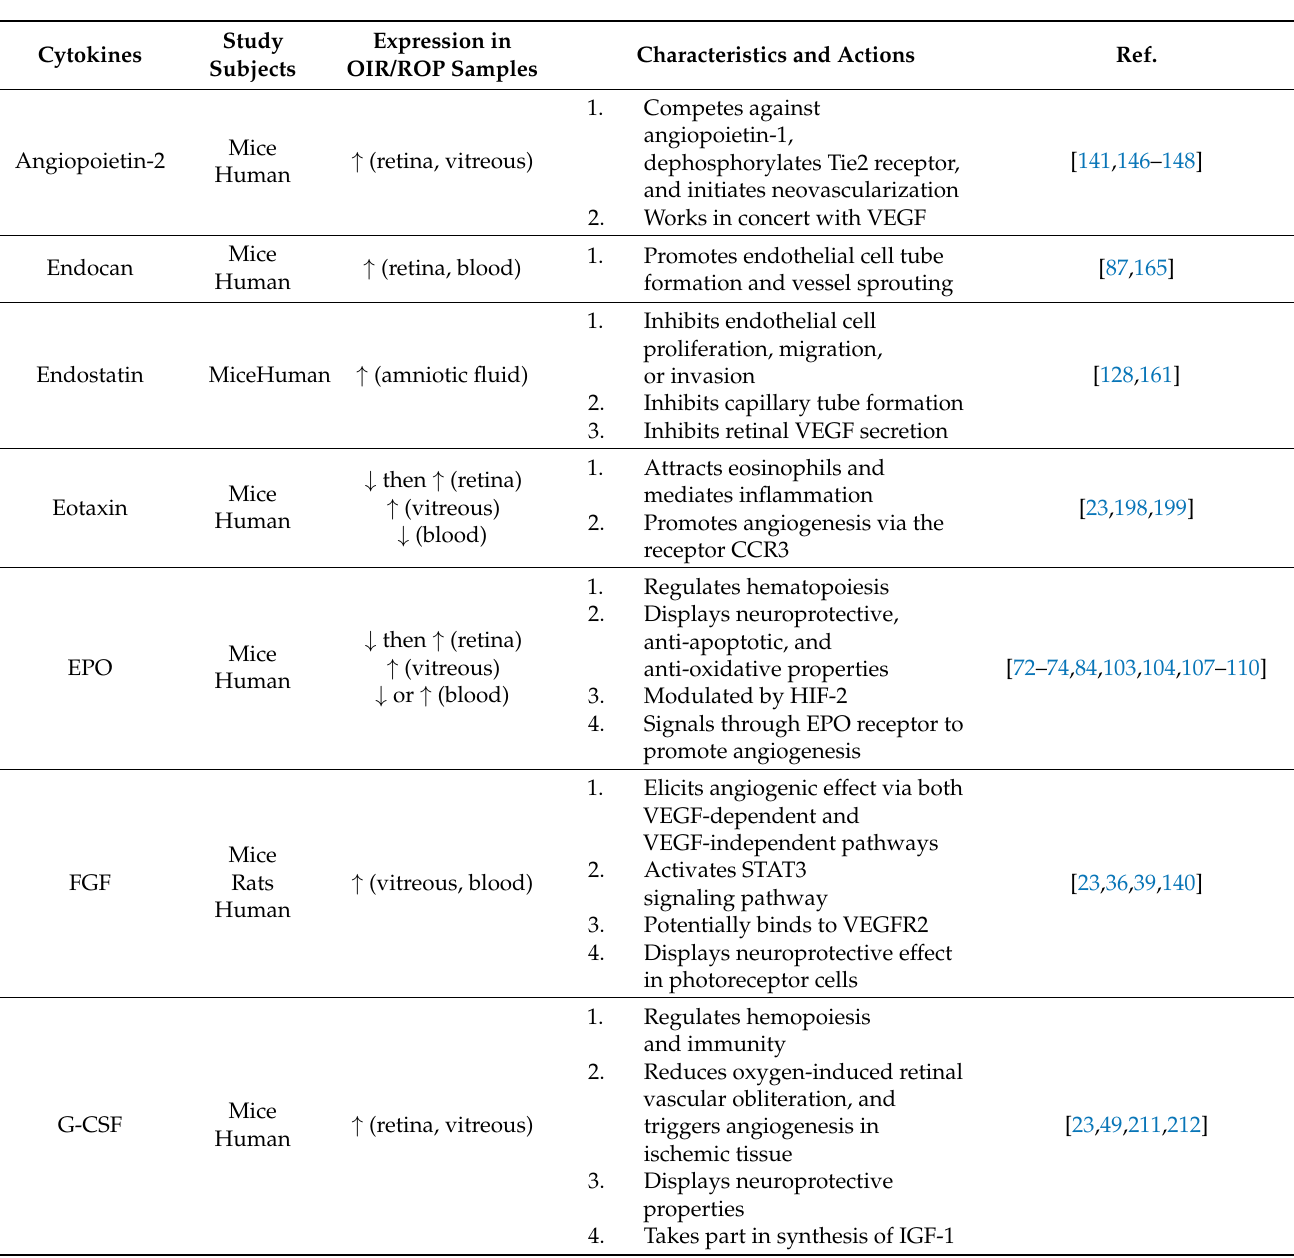
Table 1. Systemic cytokines associated with Retinopathy of